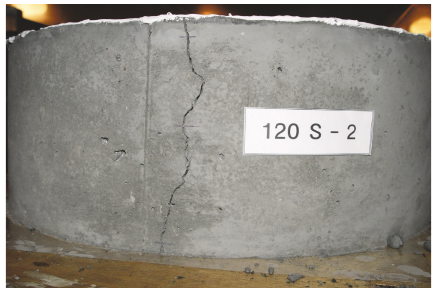
Figure 8: Cracking of ring specimen.